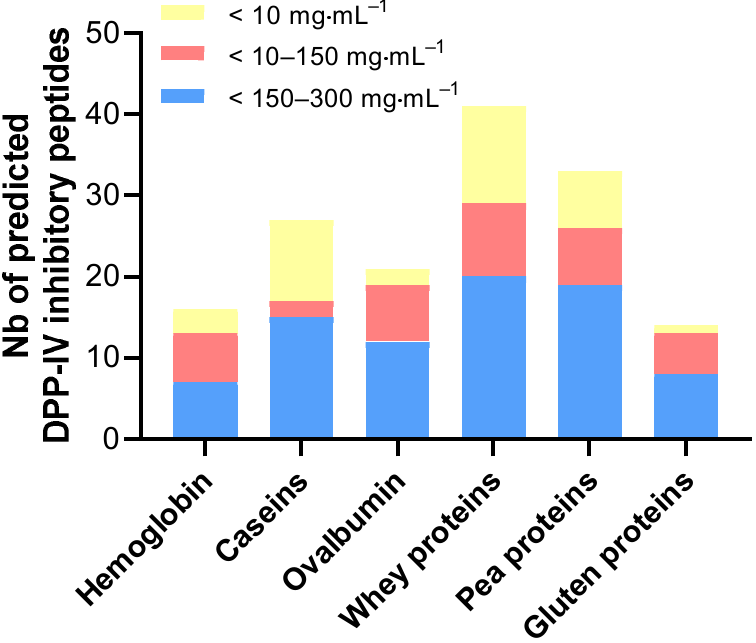
Figure 8. Number of QSAR-predicted DPP-IV-inhibitory peptides identified in the basal compartment after the IB transfer. The DPP-IV-inhibitory peptides (de novo included) are classified according to their DPP-IV IC 50 values predicted with the QSAR model (IC 50 < 10, 10–150, and 150–300 µ g · mL − 1 ) for each digested protein sample.